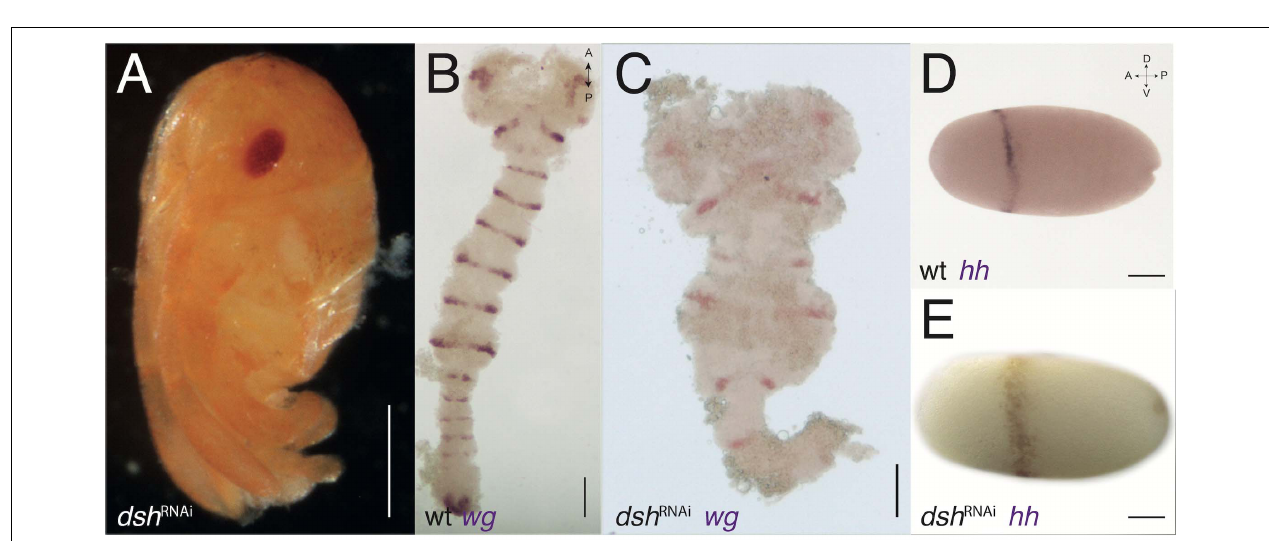
FIGURE 5 | dsh- RNAi phenotypes. (A) dsh -RNAi hatchling with no abdomen (compare with Figure 3B ). (B) Expression of wg in wild-type germband stage embryo (slightly older than the one in Figure 2E ). (C) Expression of wg in dsh- RNAi germband with normal PGS but deformed gnathal segments and missing thoracic and abdominal segments. (D) Expression of hh in wild-type blastoderm stage embryo (same embryos from Figure 1A ). (E) Expression of hh in dsh- RNAi blastoderm embryo, the anterior ring is jagged and not uniform. Axis labels: A, anterior; P, posterior; D, dorsal; V, ventral. All scale bars are 200 µ